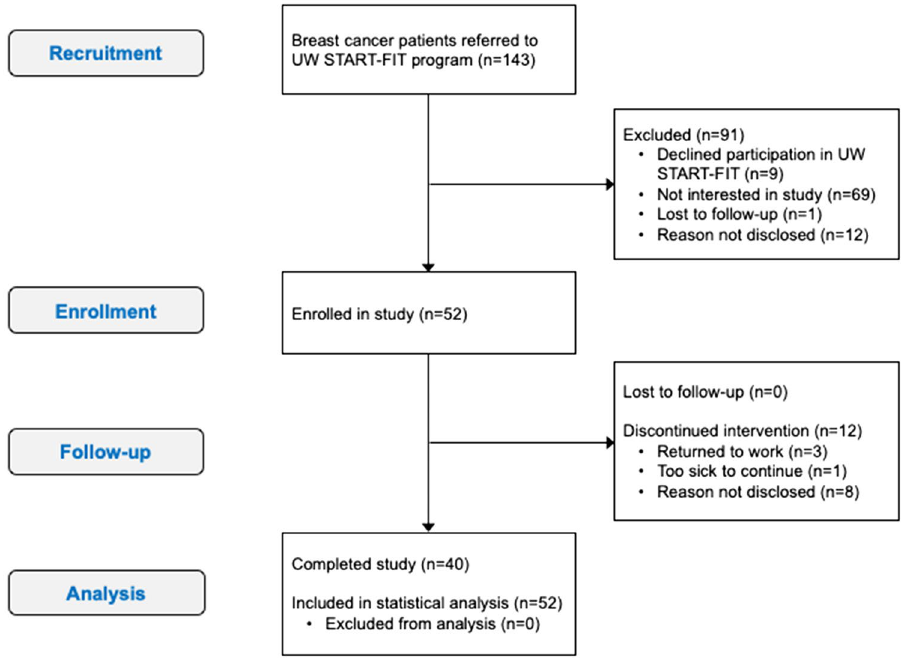
Figure 1. CONSORT flow diagram. Illustration of the movement of participants through the